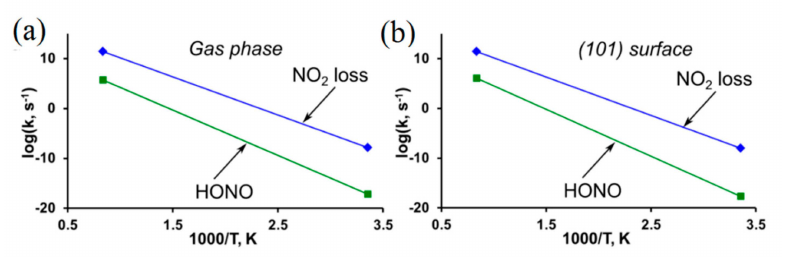
Figure 3. Reaction rates are displayed for the decomposition of PETN ( a ) in the gas phase and ( b ) on the (101) surface.